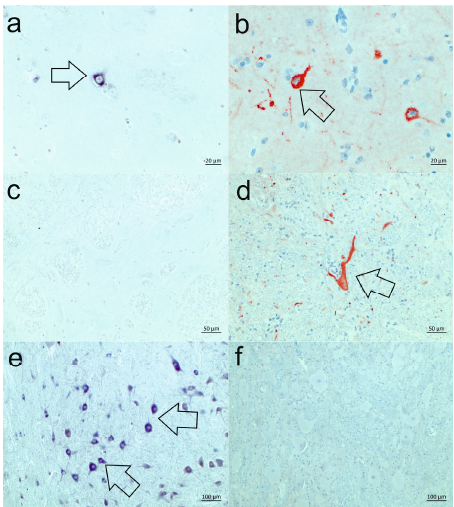
Viruses 2017 , 9 , 12 7 of 10 good correlation of ISH and IHC, with a comparable staining in neurons, as seen in the cerebrum of case 50898 ( a , b ; examples are indicated by arrows). Only in three sections can a lack of correlation be observed, with either a negative ISH ‐ result ( c ), or a red, granular staining in the IHC ( d , arrow) as seen in the brainstem of case 50898, or vice versa, in case 25018: a deep purple ISH staining in neurons of the brainstem ( e , arrows) is observed, while the IHC remains negative ( f ).